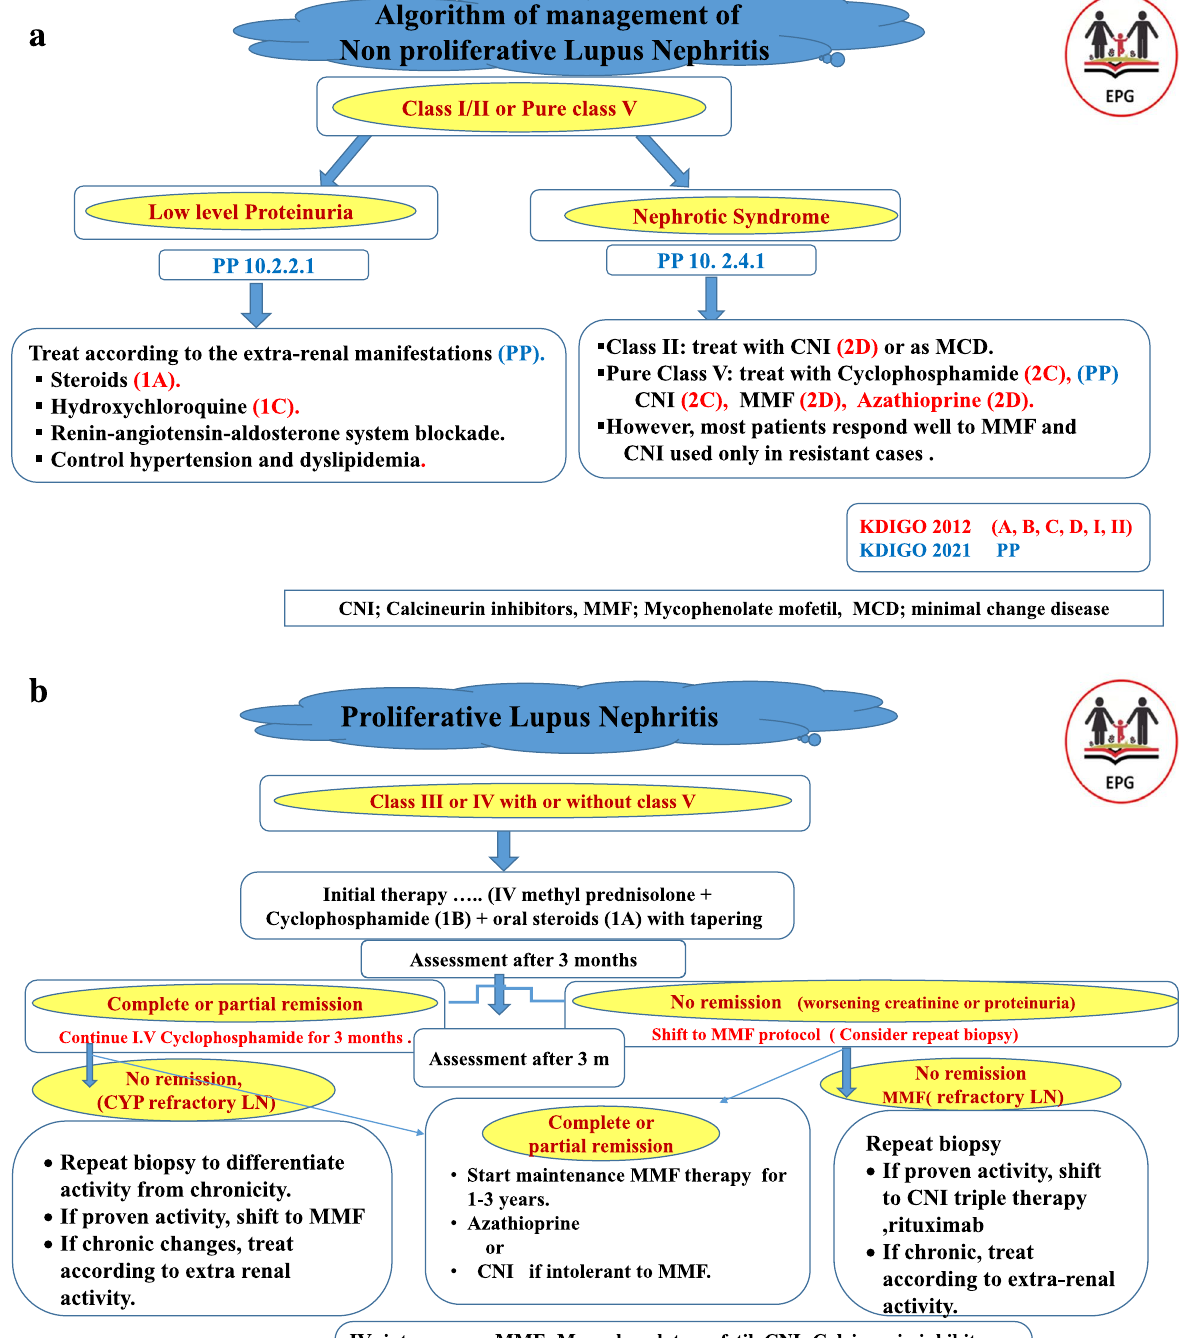
Fig. 4 a EPG management of lupus nephropathy classes I, II, and V (pure MN) R 3.2.2D. b EPG management of lupus nephropathy classes III and IV. R 3.2.2